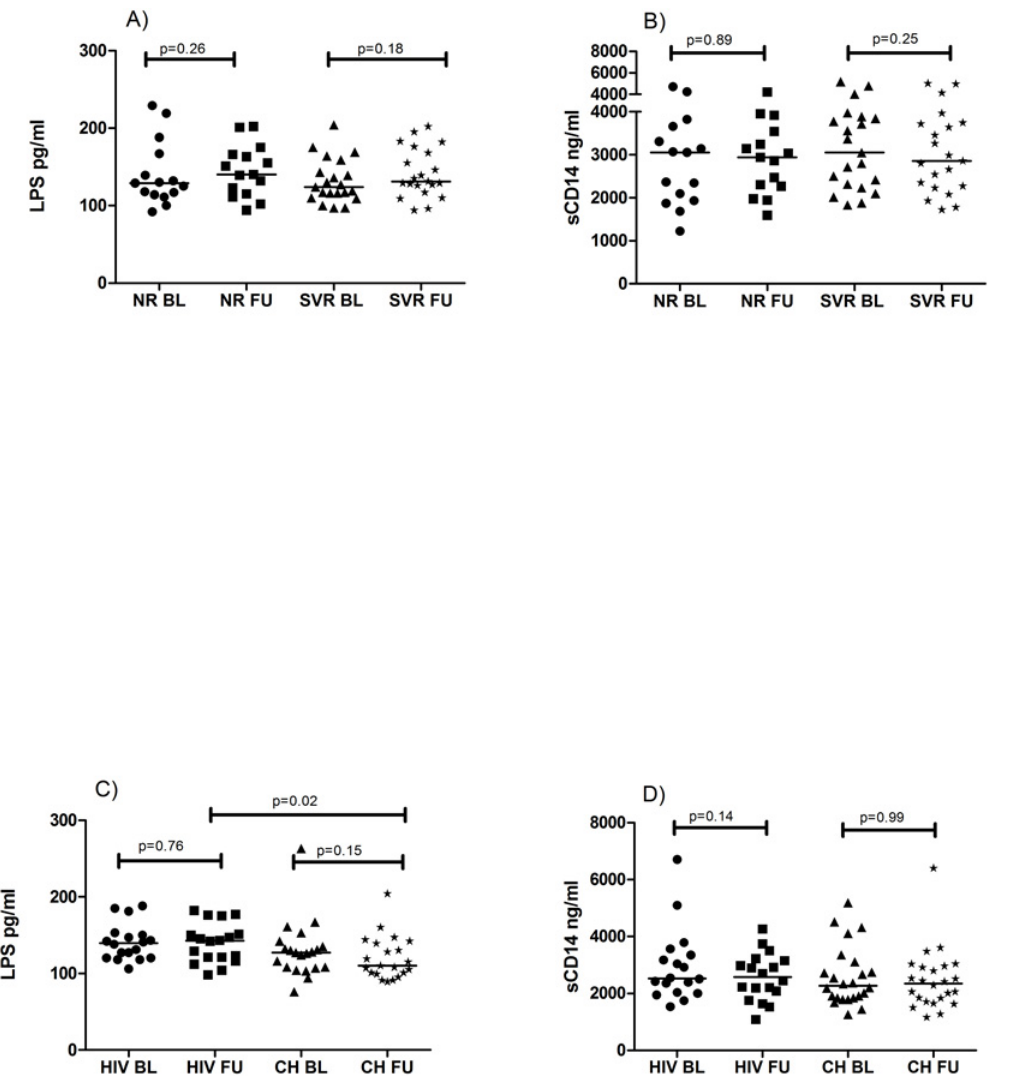
Fig 3. Kinetics of LPS and sCD14. A-D) Baseline (BL) and follow-up (FU) levels of LPS and sCD14 during the study time were compared between Sustained viral responders (SVR) and non-responder (NR) group (A-B) and between HIV and HCV chronic (CH) group (C-D). Wilcoxon matched-pairs signed rank test was used for assessing changes between baseline and follow-up. Mann Whitney U test was used to assess the differences between the groups at the same time point, p (cid:3) 0.05 was considered significant. (Fig. 3C). At baseline the sCD14 levels were akin in HIV and CH p = 0.23 (Table 1) and did